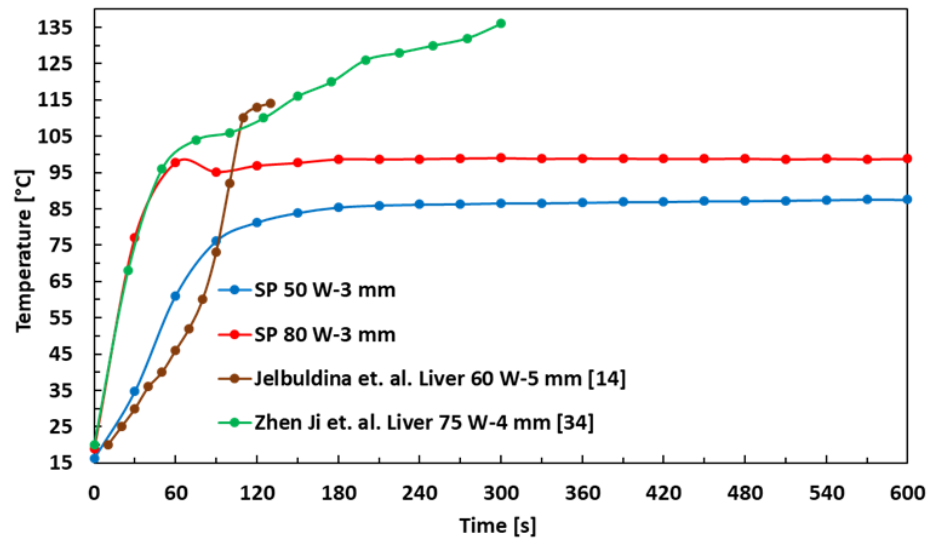
Figure 10. Temperature vs. time in MWA experiments [14,34].